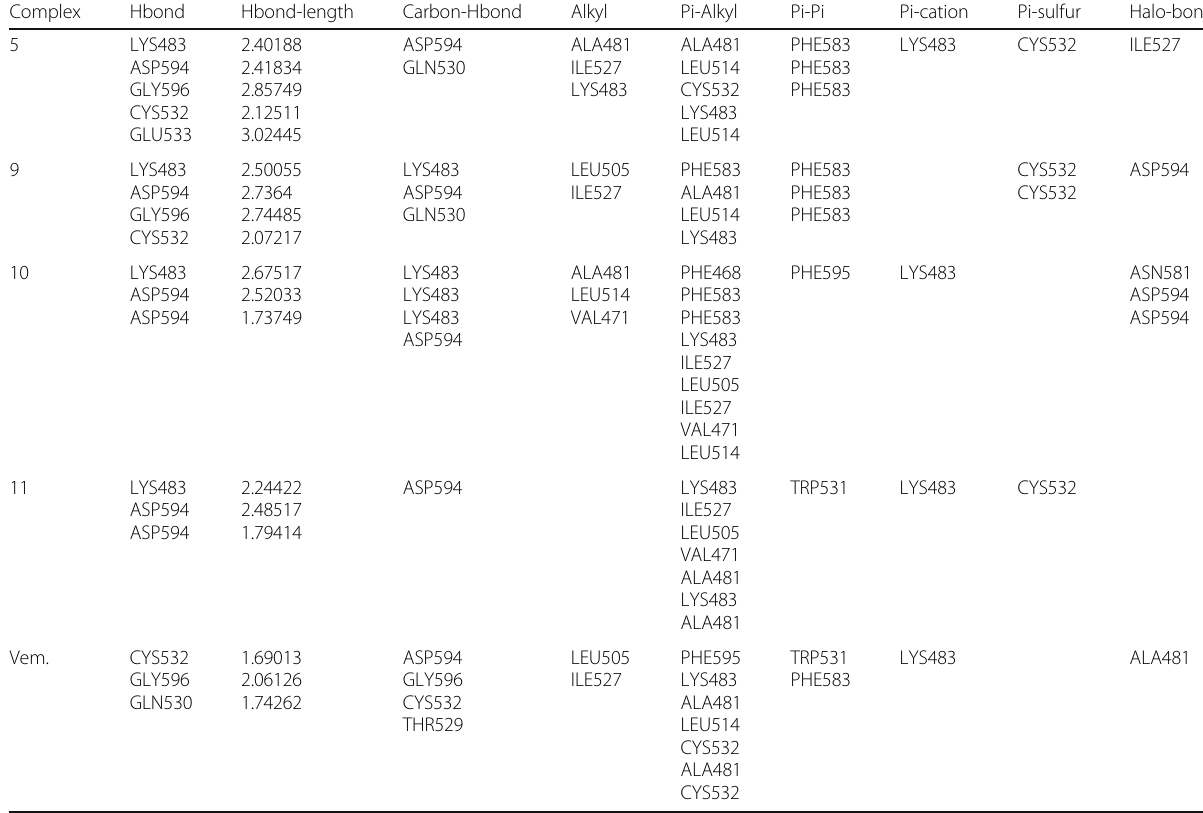
Table 1 The docking results (scores) of the studied compounds with Vemurafenib as the reference